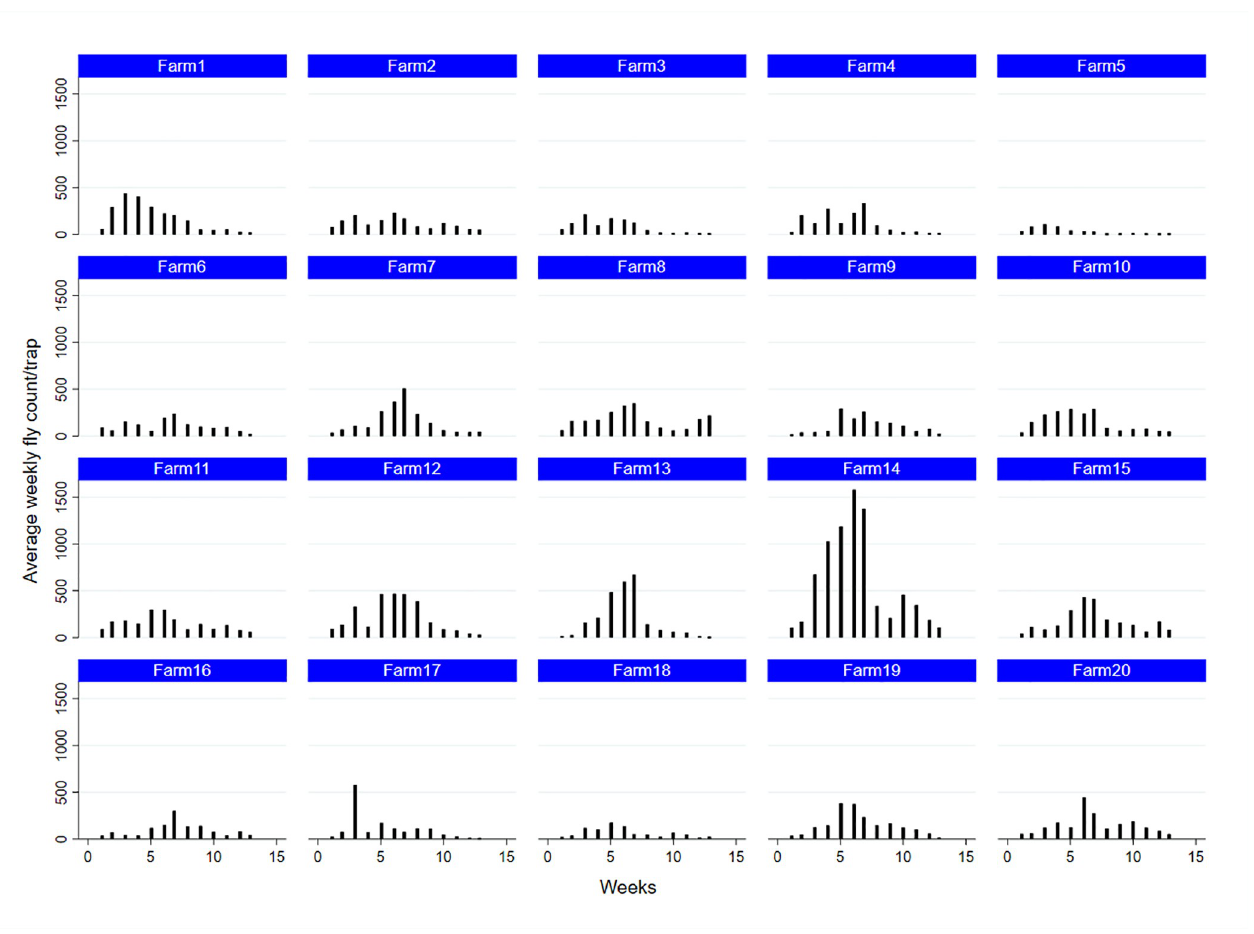
Fig 3. Weekly mean stable fly trap count using five Alsynite traps on each of 20 study dairies over 13 weeks from May1st to July 31st, 2017 during the peak stable fly activity season in the San Joaquin Valley of California.